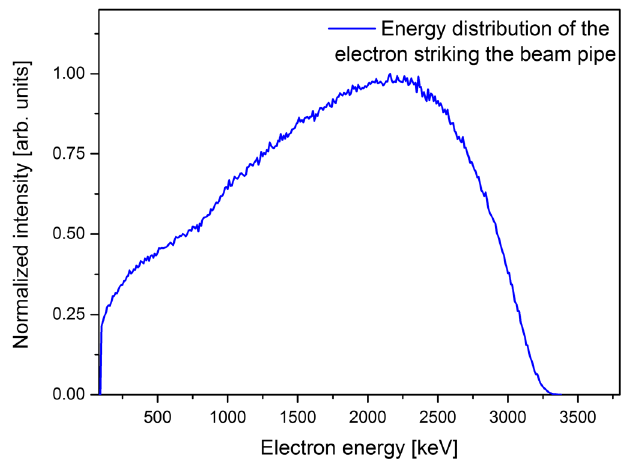
FIG. 8. Simulated time integrated energy distribution of the loss electrons striking the